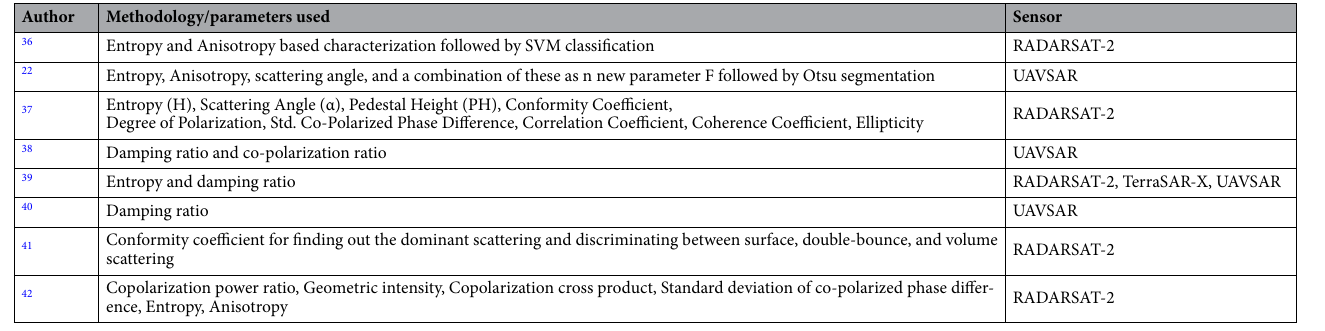
Table 1. Most frequently used polarimetric parameters in the literature for oil spill